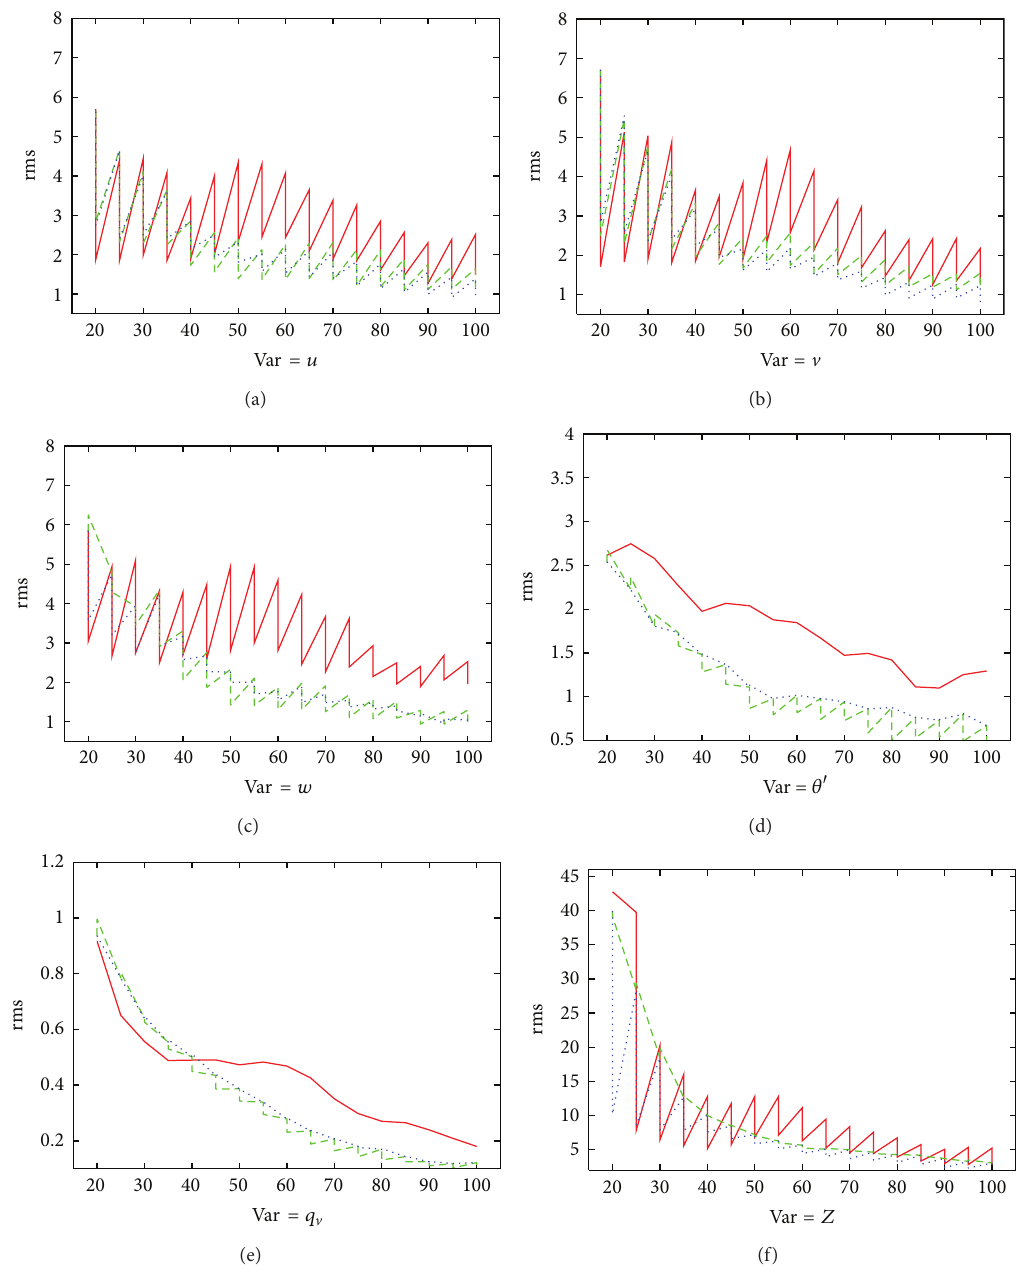
Figure 6: The same as Figure 4 but for the experiment with two